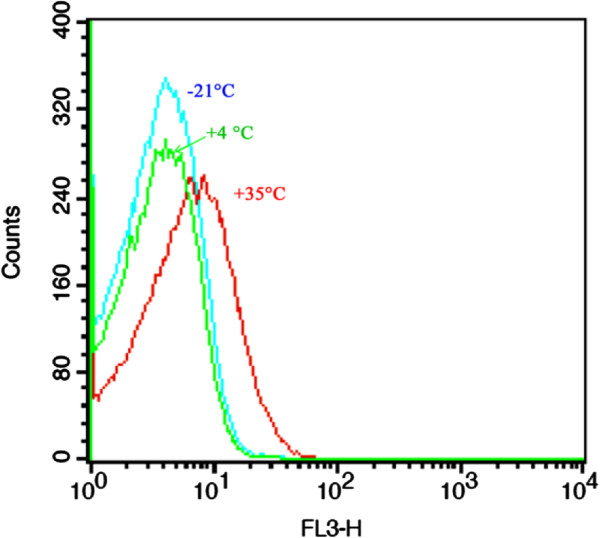
Auto fluorescence feature of freeze-dried A. senegalensis kept at different storage temperatures for 12 months. Light emitted from cells was collected and appeared on FL3. A significant difference (p < 0.05) was observed between the light intensity mean of cells kept at 35°C and the light intensity mean of cells stored at −21 or 4°C.